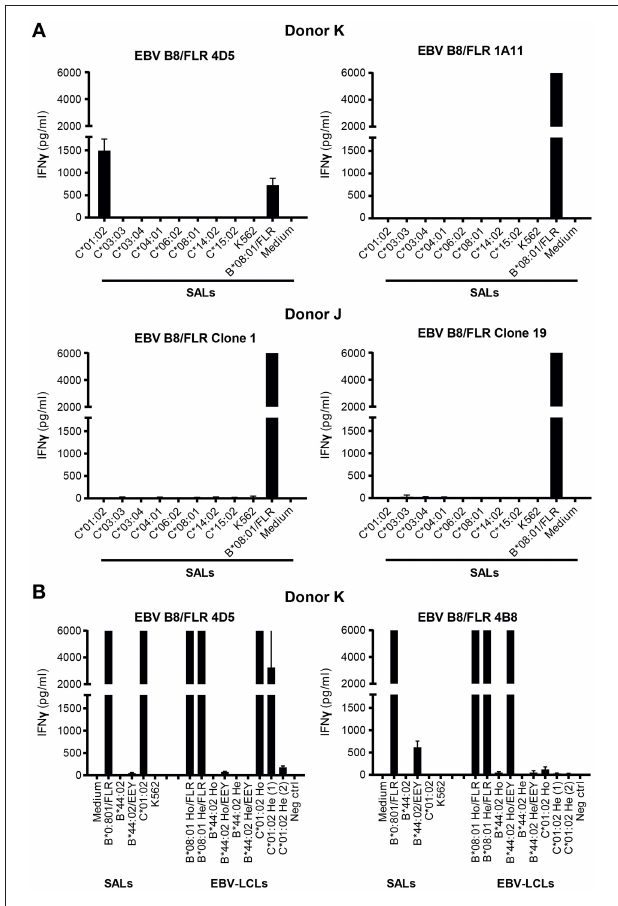
FIGURE 1 | Alloreactivity of EBV B8/FLR T cell clone 4D5 against HLA-C * 01:02. (A) EBV B8/FLR T cell lines ( n = 9; 1A11 shown) and T cell clones ( n = 6; 4D5, clone 1, and clone 19 shown) were stimulated with a panel of HLA-C expressing SALs after which IFN γ production was measured. EBV B8/FLR T cell clone 4D5 showed alloreactivity against HLA-C*01:02. (B) One EBV B8/FLR T cell line and four EBV B8/FLR T cell clones (4B8 and 4D5 shown) were stimulated with a panel of SALs and EBV-LCLs expressing HLA-B*08:01, HLA-C*01:02, and HLA-B*44:02 alleles after which IFN γ production was measured. The range of the ELISA standard curve: 5–5120 pg/ml; Ho, homozygous; He, heterozygous. Bars represent duplicate values with standard deviation of the